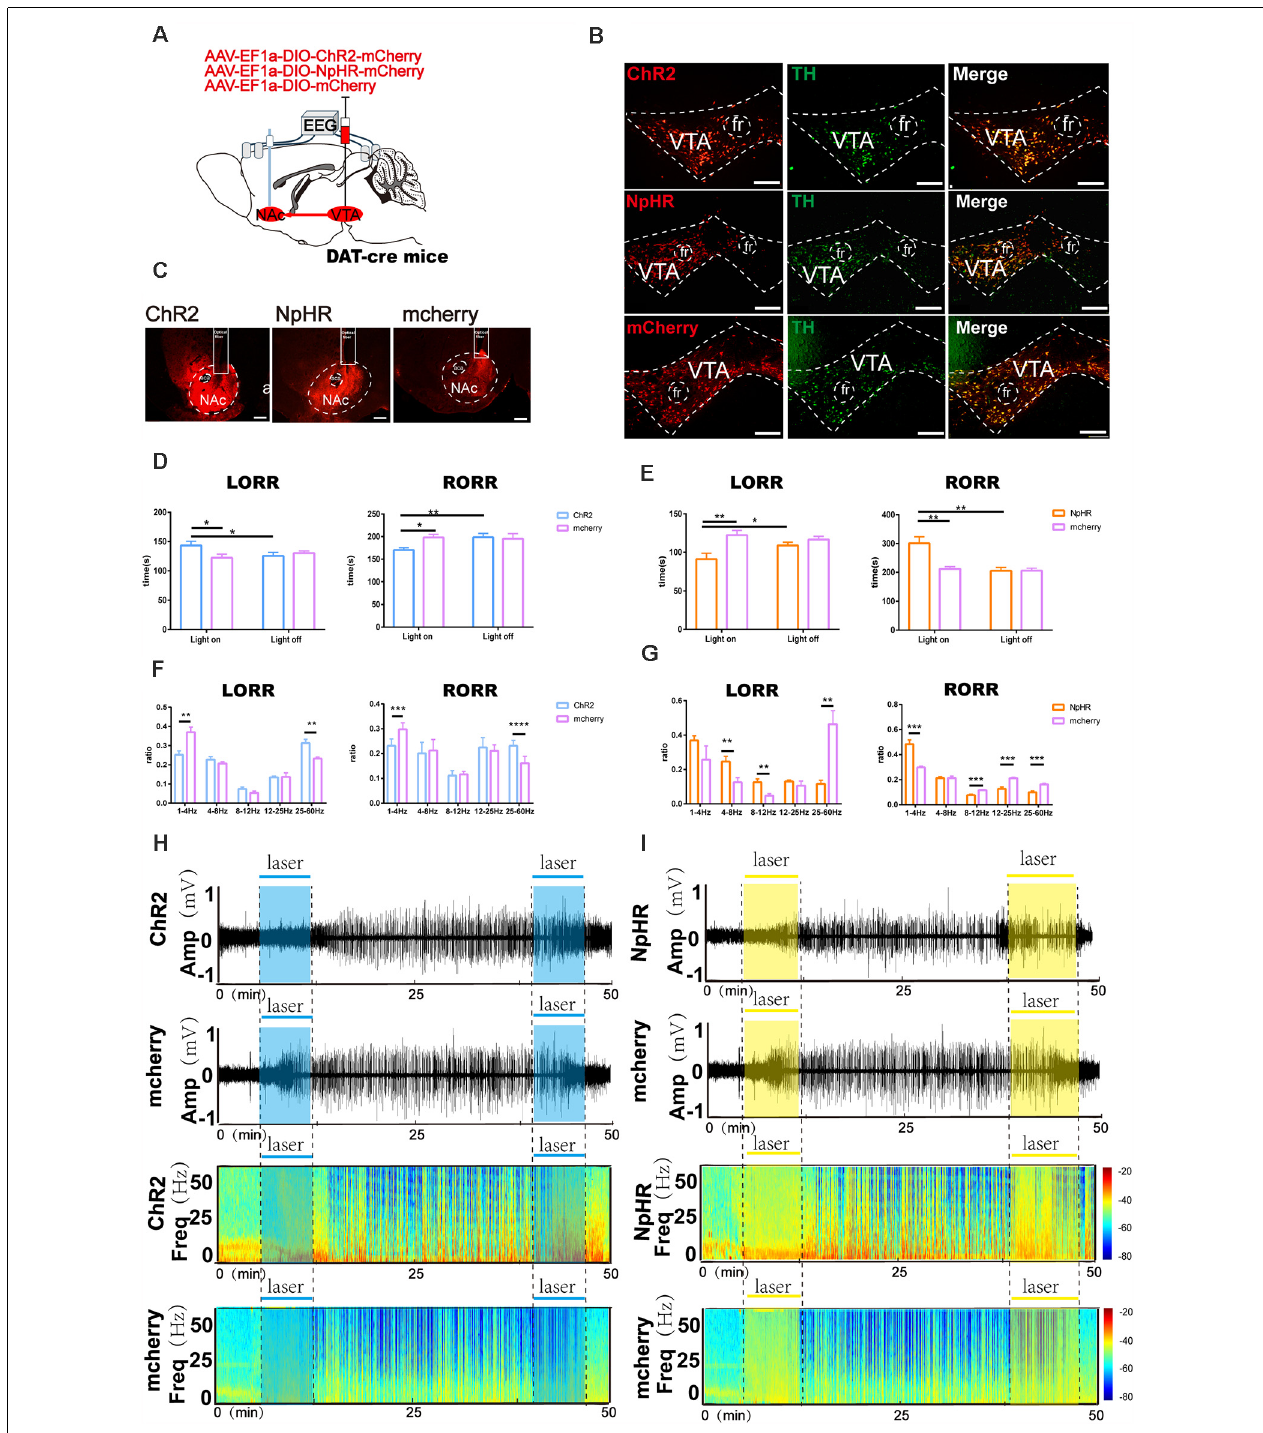
FIGURE 7 | Optogenetic activation or inhibition of VTA DA -NAc projections modulate the process of sevoflurane anesthesia. (A) Schematic of optogenetic virus injection and stimulation sites. (B) Expression of ChR2/NpHR/mCherry (red) and TH immunofluorescence (green) in the VTA. (C) Expression of VTA-DA neuron terminals in the NAc. (D) Optical stimulation of VTA dopaminergic projections in the NAc prolonged the induction time and reduced the emergence time. (E) Optical inhibition of dopaminergic terminals in the NAc reduced the induction time and prolonged the emergence time. (F) Optogenetic activation of dopaminergic terminals mediated the band distribution of EEG power during both the LORR and RORR process. (G) Optogenetic inhibition of VTA dopaminergic projection to the NAc mediated the band distribution of EEG power during both the LORR and RORR processes. (H,I) Representative EEG traces and heat map from each group. Data are presented as the mean ± SD. * p < 0.05, ** p < 0.01, *** p < 0.001, and **** p < 0.0001, n = 8, by paired and unpaired t -test.